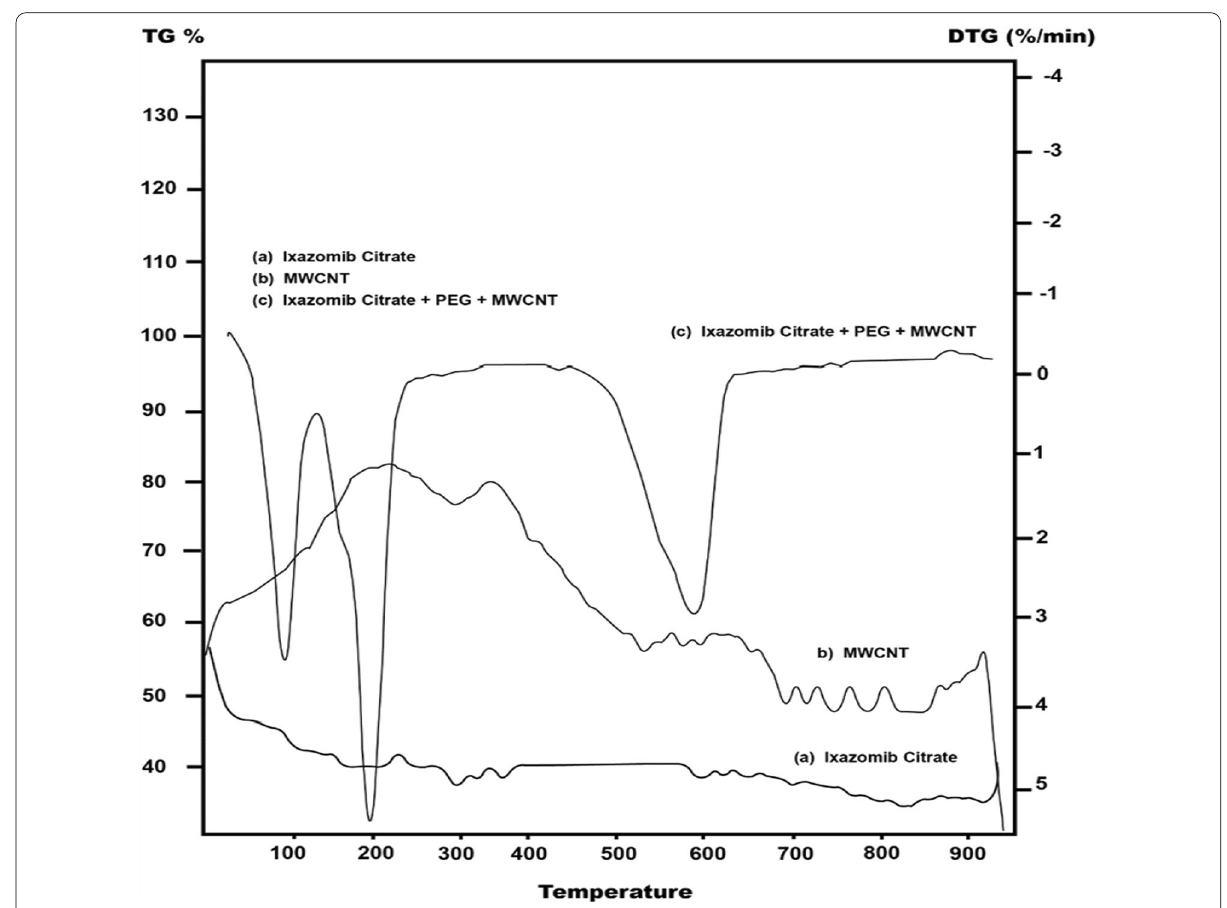
Fig. 7 The DTG curve of Ixazomib citrate, MWCNT, and the composite